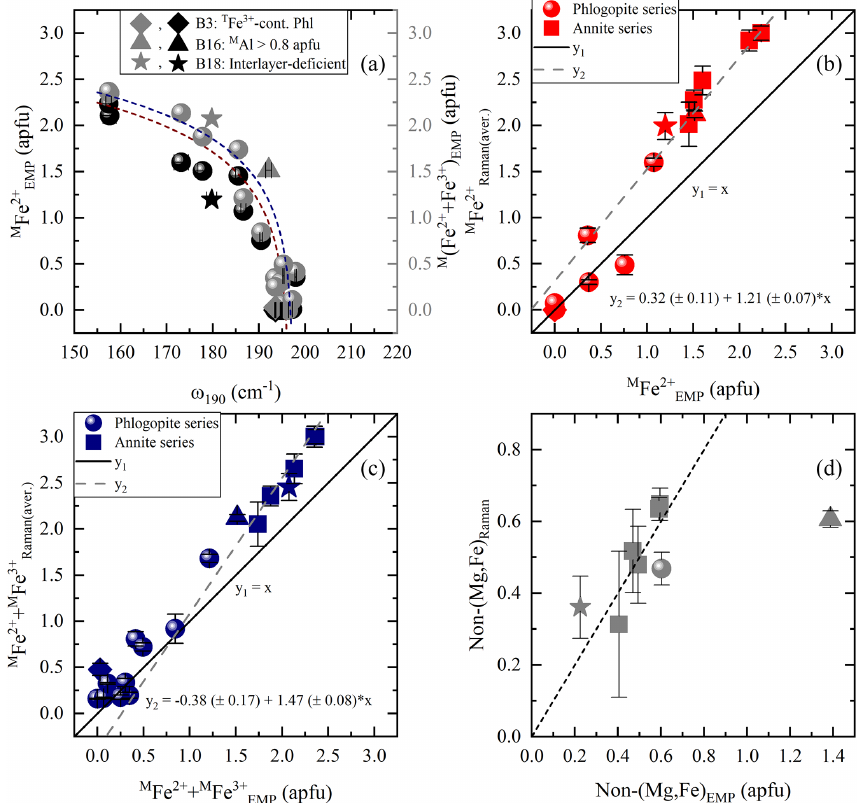
Figure 6. Estimation of M Fe 2 + and M (Fe 2 + + Fe 3 + ) contents according to MO 6 vibrations and OH-stretching peaks: (a) M Fe 2 + amount vs. Raman peak position at 190cm − 1 (black symbols) and M (Fe 2 + + Fe 3 + ) content vs. ω 190 (gray symbols), (b) M Fe 2 + from the Raman spectroscopic analysis ( M Fe 2 + ) of the OH-stretching vibrations vs. that calculated from EMPA ( M Fe 2 + ), and (c) M (Fe 2 + + Fe 3 + ) from Raman EMP the Raman spectroscopic analysis ( M (Fe 2 + + Fe 3 + )) of the OH-stretching region vs. that calculated from EMPA ( M (Fe 2 + + Fe 3 + )). Raman EMP (d) Non-(Mg,Fe) cationic content at the M site of the samples deviating from the one-to-one correlation lines of Fig. 6b and c, where the non- (Mg,Fe) amount from the Raman spectroscopic analysis (non-(Mg,Fe) Raman ) was plotted vs. that calculated from EMPA (non-(Mg,Fe) EMP ). Deviating data points mentioned in the legend are same as in Fig.